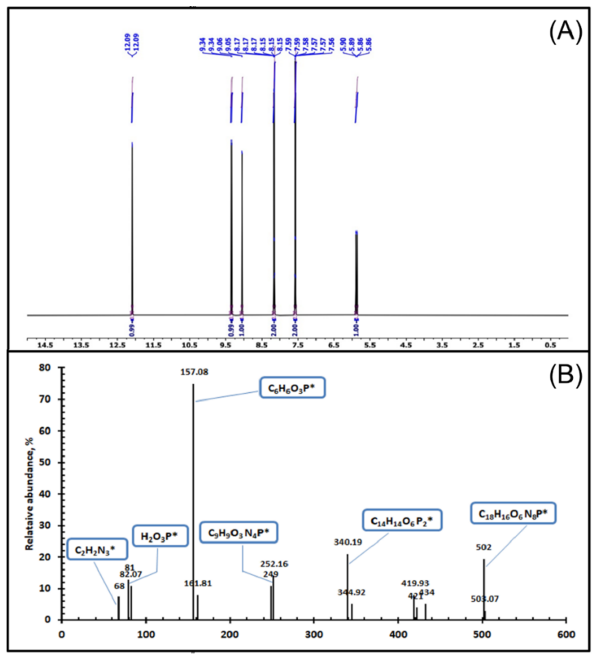
Figure 2. ( A ) 1 H ‐ NMR analysis of TIHP. ( B ) GC ‐ Mass analysis of TIHP